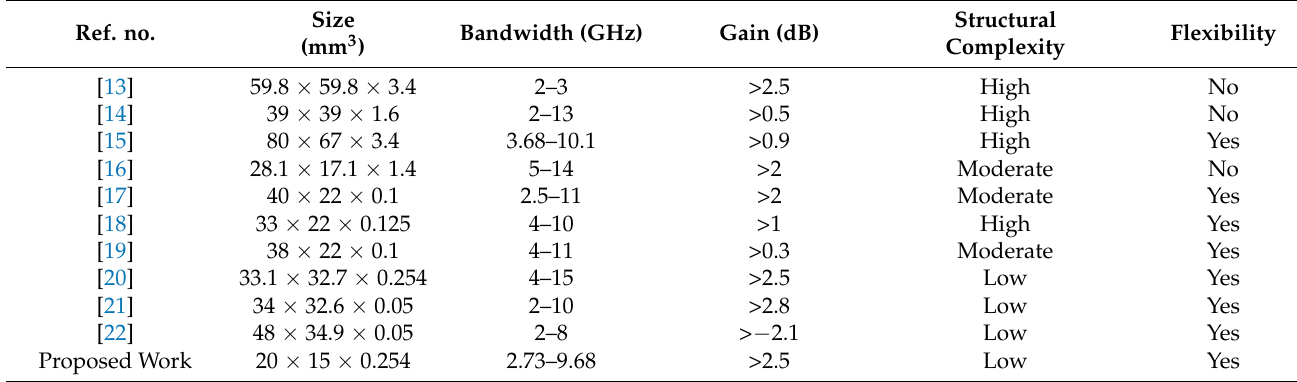
Table 1. Comparison with